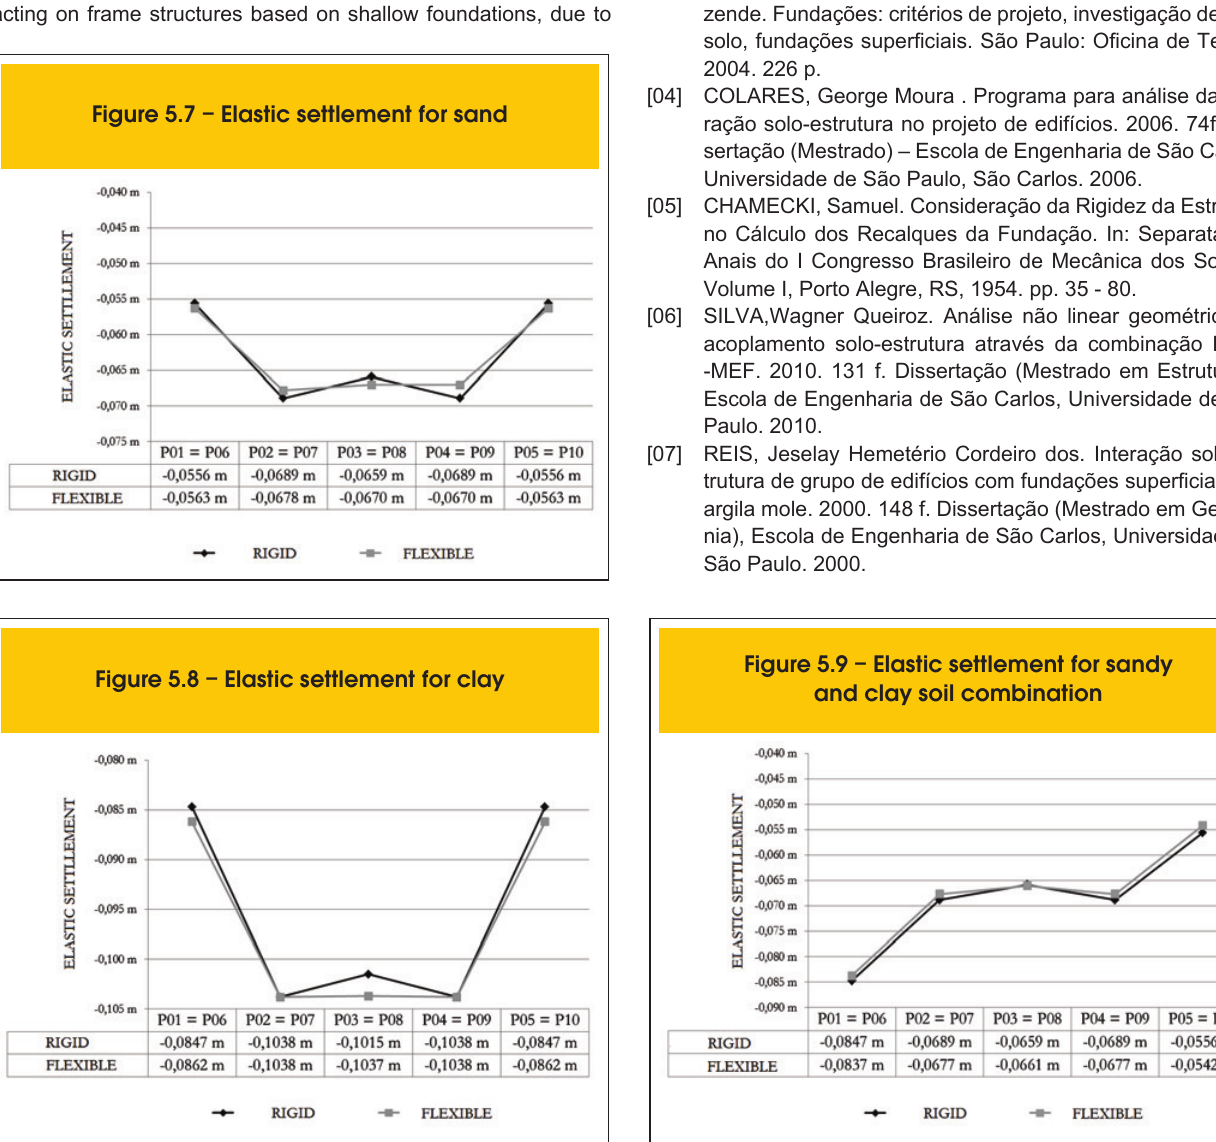
Figure 5.7 – Elastic settlement for sand